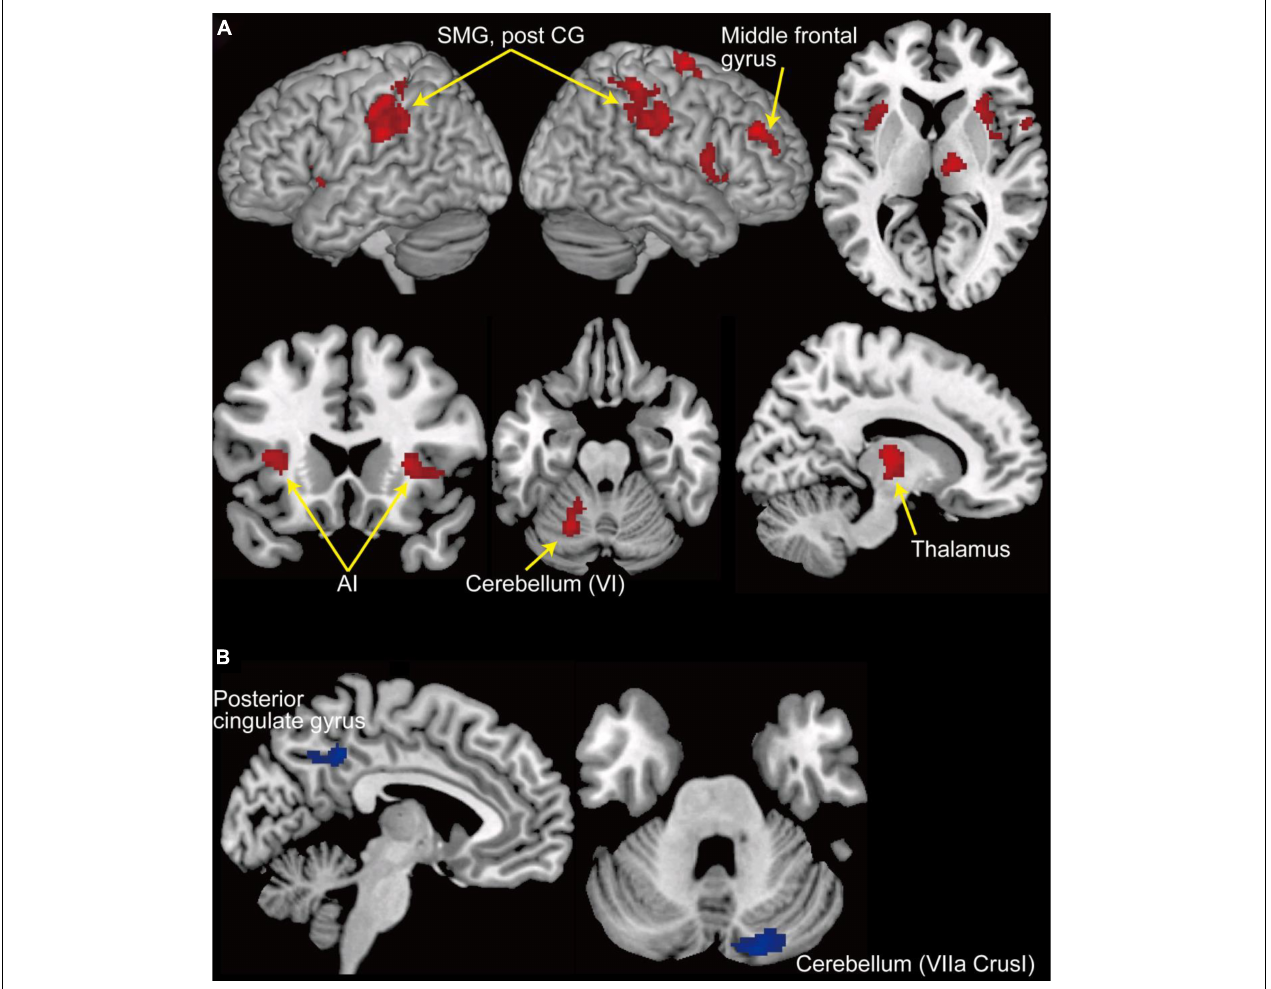
FIGURE 4 | GLM results. (A) Clusters of activation (in red) that significantly increased after change in the level of accelerator sensitivity. (B) Clusters of activation (in blue) that significantly decreased after change in the level of accelerator sensitivity. A threshold at p < 0.05 (FWE-corrected at cluster level with a cluster-forming threshold of p < 0.001) was set for statistical testing. AI, anterior insula; Post CG, post central gyrus; SMG, supramarginal